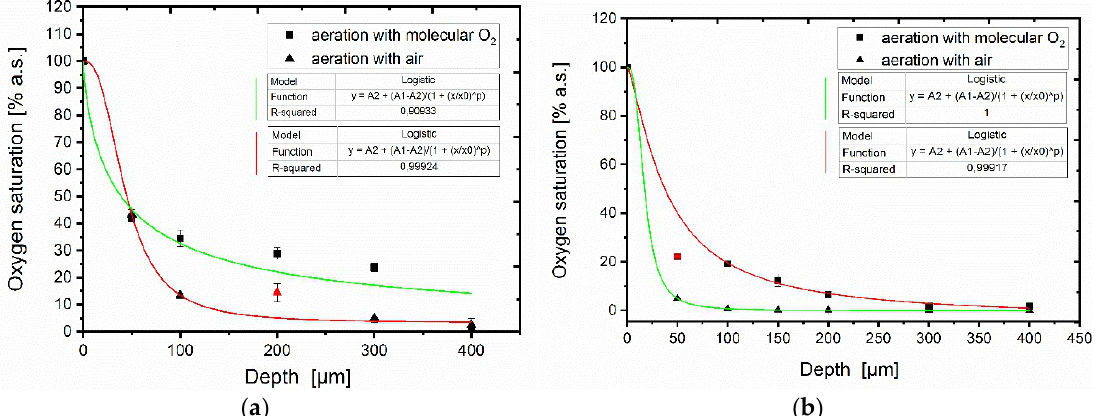
Figure 4. Oxygen depth profile in agarose (1% ( w / v )) encapsulating the bioluminescent strain containing the yqjF :: luxCDABE fusion at two cell densities. An oxygen microprobe was polymerized into the gel and the bottom side of the gel was aerated either with oxygen or air and the oxygen saturation was measured once it reached a stationary point. The distance between the lower edge of the shot sleeve (see Figure A7) and the tip of the oxygen probe was used to display oxygen penetration OD 600 = 1 ( a ), OD 600 = 5 ( b ).